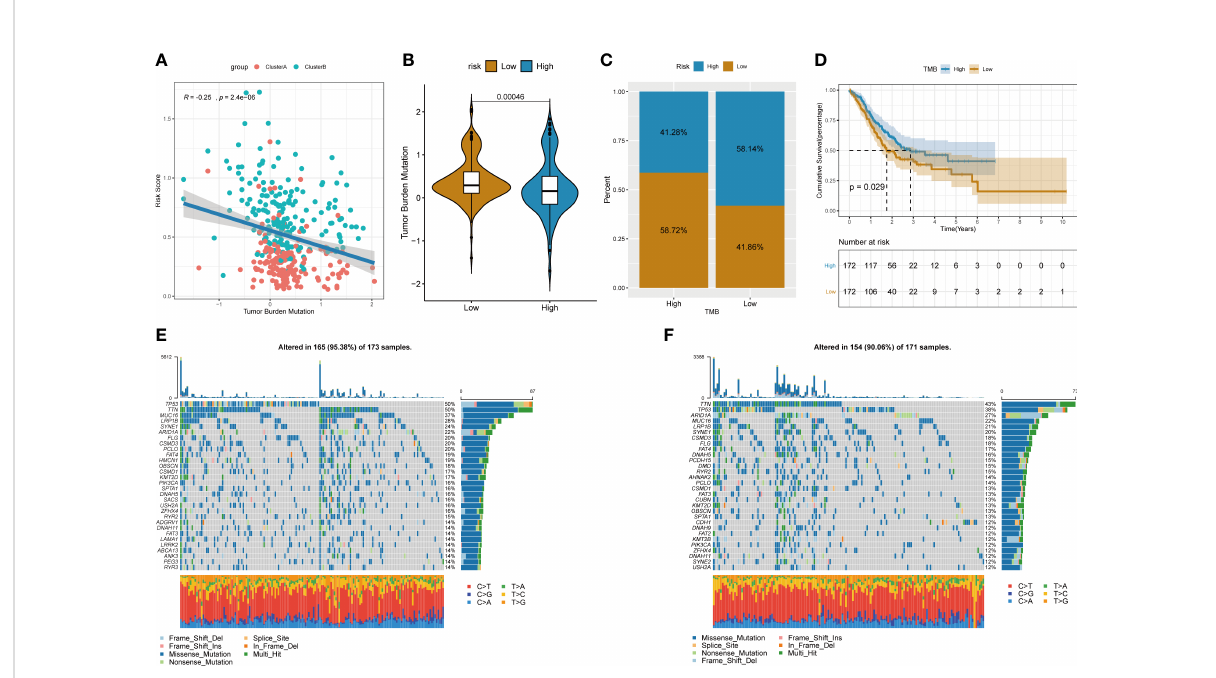
FIGURE 10 Relationship between tumor risk score and tumor mutational burden. (A) Correlation linear regression analysis; (B) Violin plot; (C) Bar chart of proportional distribution; (D) Survival curve; (E) Waterfall chart of gene mutation in high risk group; (F) Waterfall chart of gene mutation in low risk